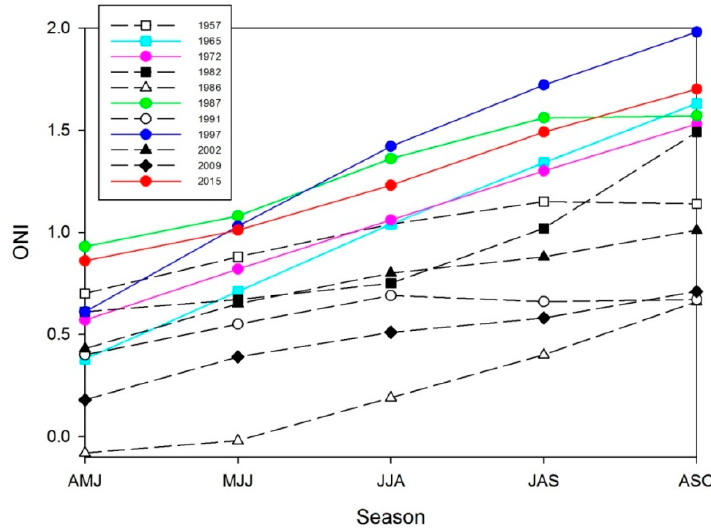
Figure 2. Recent (historic) and the 2015 observed El Niño events, based on Niño 3.4 sea surface temperature (SST) anomalies as quantified by the ONI. The x -axis shows three-month average (running mean) periods. Solid (colored) lines represent the four El Niño events similar to and the observed 2015 event. Dashed (black) lines represent dissimilar El Niño